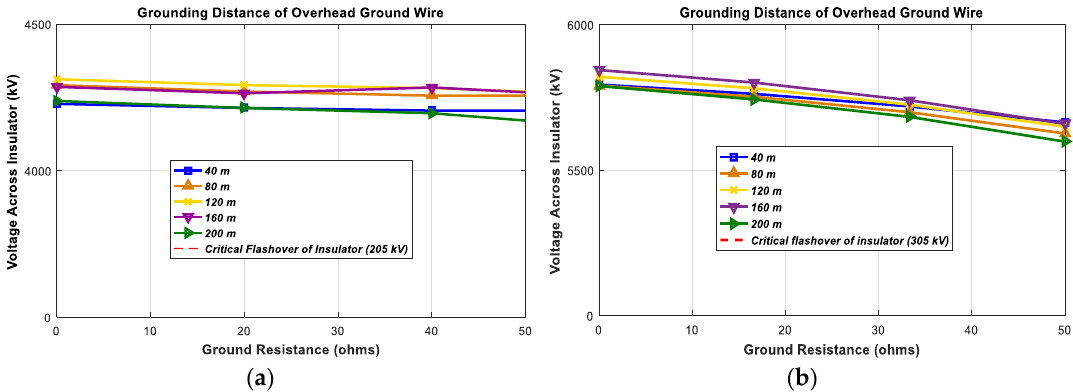
Figure 7. Result of a lightning strike to the phase conductor; ( a ) Strike to the phase conductor (middle); ( b ) Strike to the phase conductor (end).